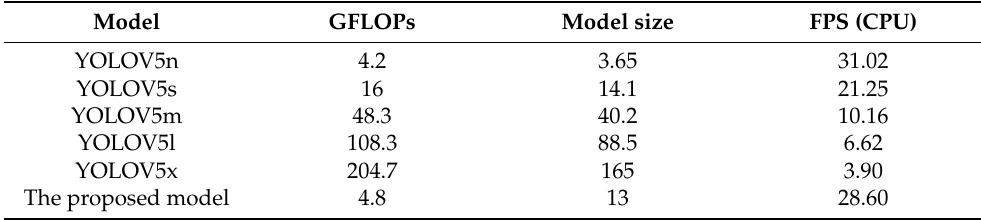
Table 3. Comparing the model complexity analysis of the proposed model with five different versions of